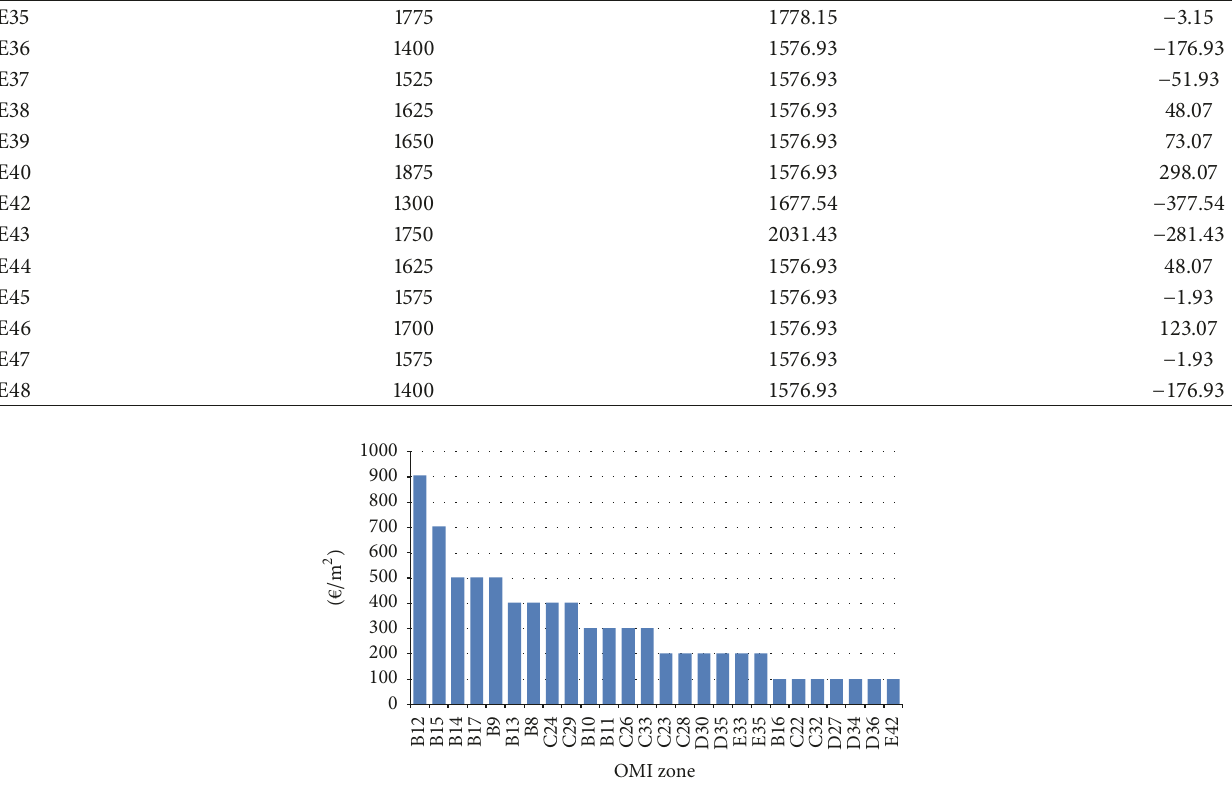
Figure 12: Contribution of high-frequency rail stations to real estate values